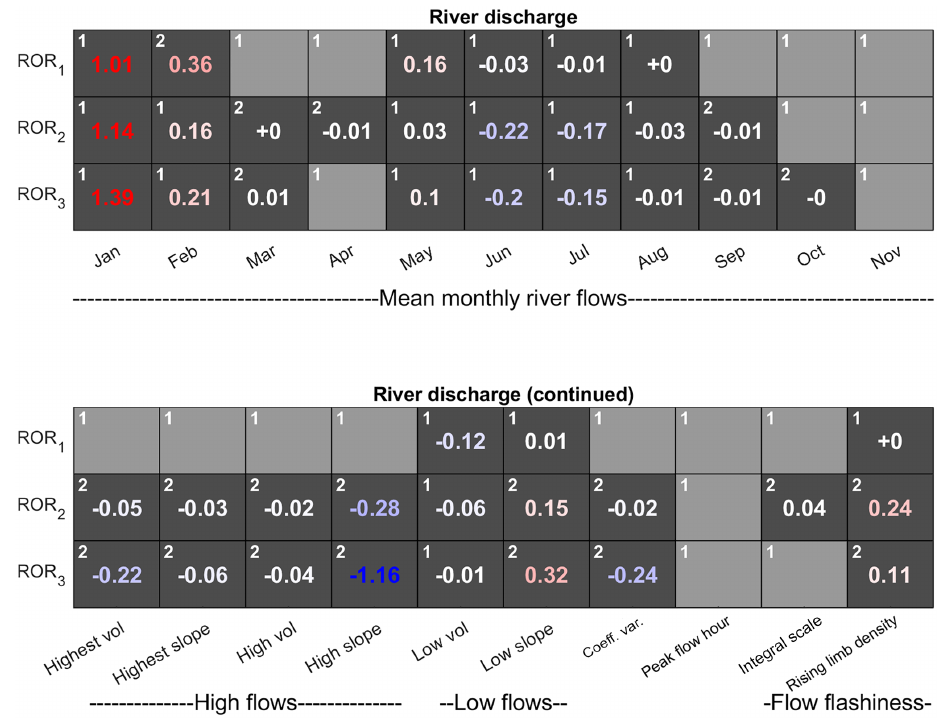
Figure 15. Acceptability scores obtained after calibrating the GHM using the three run-off-routing model structures in combination with the TIM 1 melt model structure. Light-grey boxes indicate acceptable simulations ( s = 0) and numbered dark-grey boxes indicate unacceptable simulations, coloured blue and red to indicate negative and positive biases respectively. Note that all acceptability scores are rounded to two decimal places. Those non-zero scores that round to zero are accompanied by ± to indicate sign of score. White numbers in top left of each box indicate relative ranking where acceptability scores are substantially different between the GHM